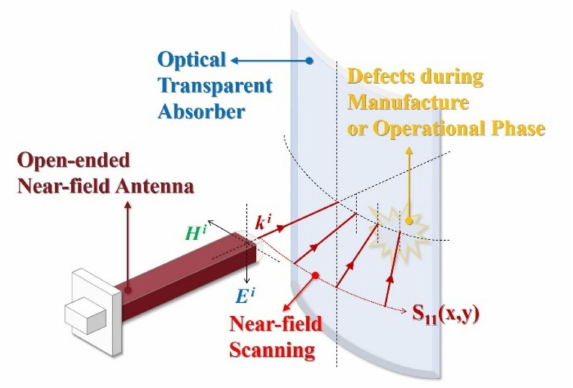
Figure 1. Illustration of the evaluation scenario for an optical transparent absorber with a three- dimensional